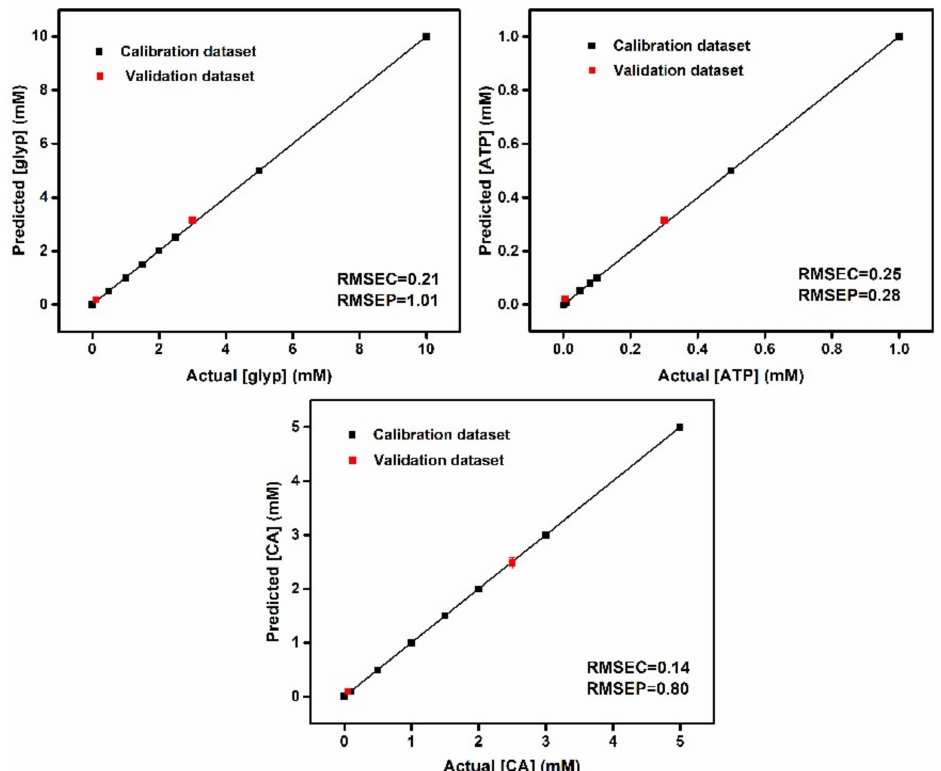
Figure 10. Regression analysis for quantitative estimation of oxyanion concentrations of Glyp, CA and ATP in mixtures (in 10 mM of MES buffer). Detailed concentrations are summarized in SI. Plots of actual concentrations versus predicted concentrations show high prediction accuracy for multiple concentrations of each analyte. Root-mean-square errors (RMSEs) of calibration (C) and prediction (P) attest to the high quality of the model and